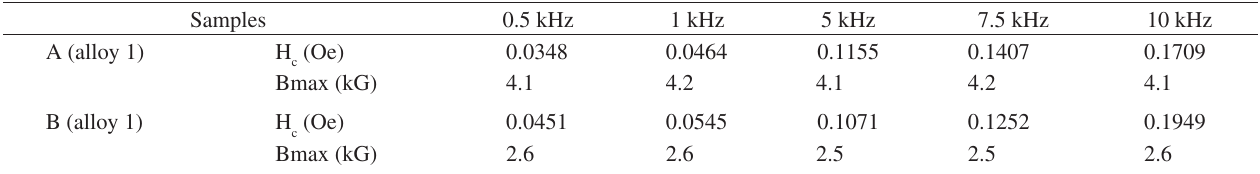
Table 1. Values of Hc (Oe) and Bmax (kG) resulting from frequency variation imposed on samples A and B.